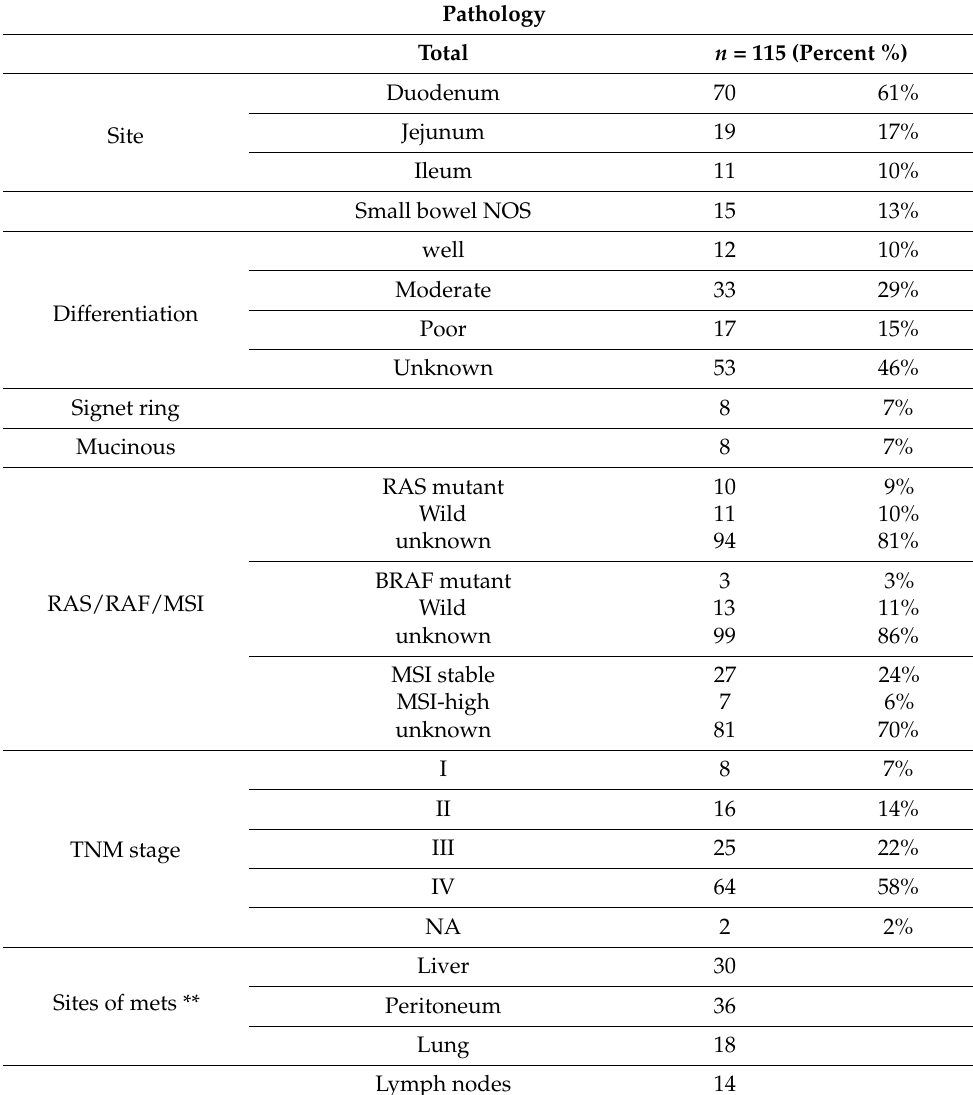
Table 2. Pathology and staging